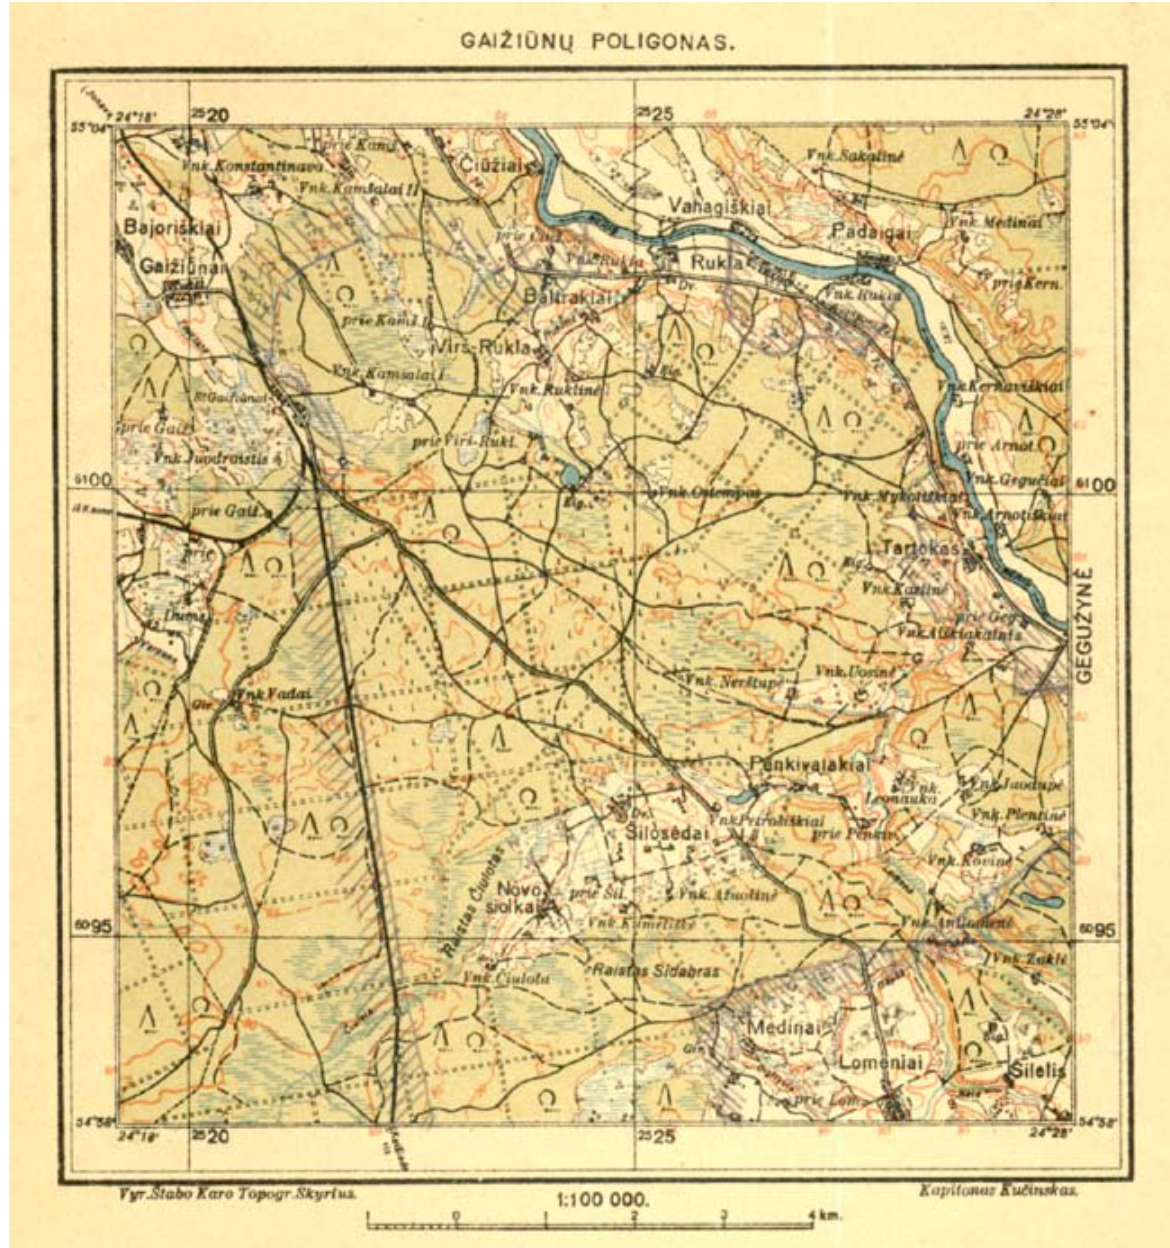
Fig. 4 . Gaižiūnai military ground map, scale 1:100